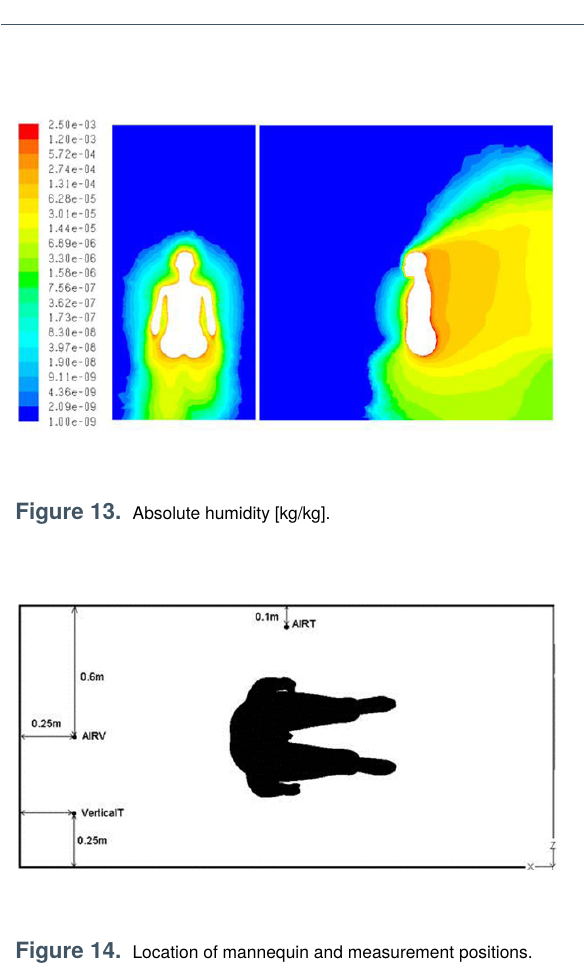
Figure 14. Location of mannequin and measurement positions.